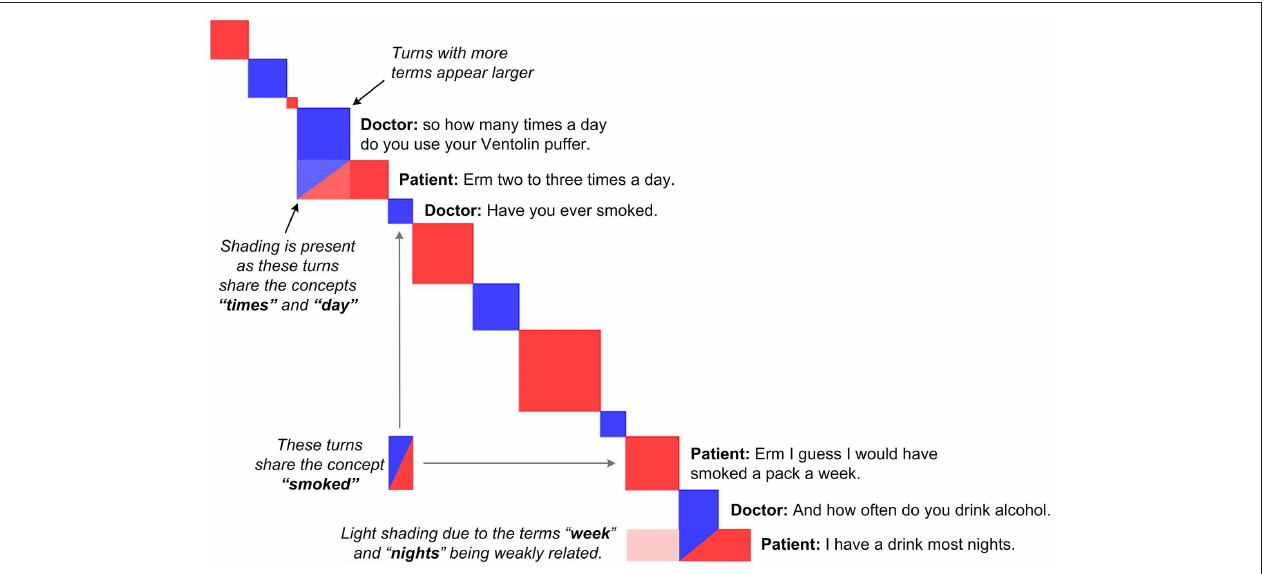
FIGURE 1 | An example conceptual recurrence plot of an interaction between a doctor and patient. Reproduced from Angus et al. [15] with permission.